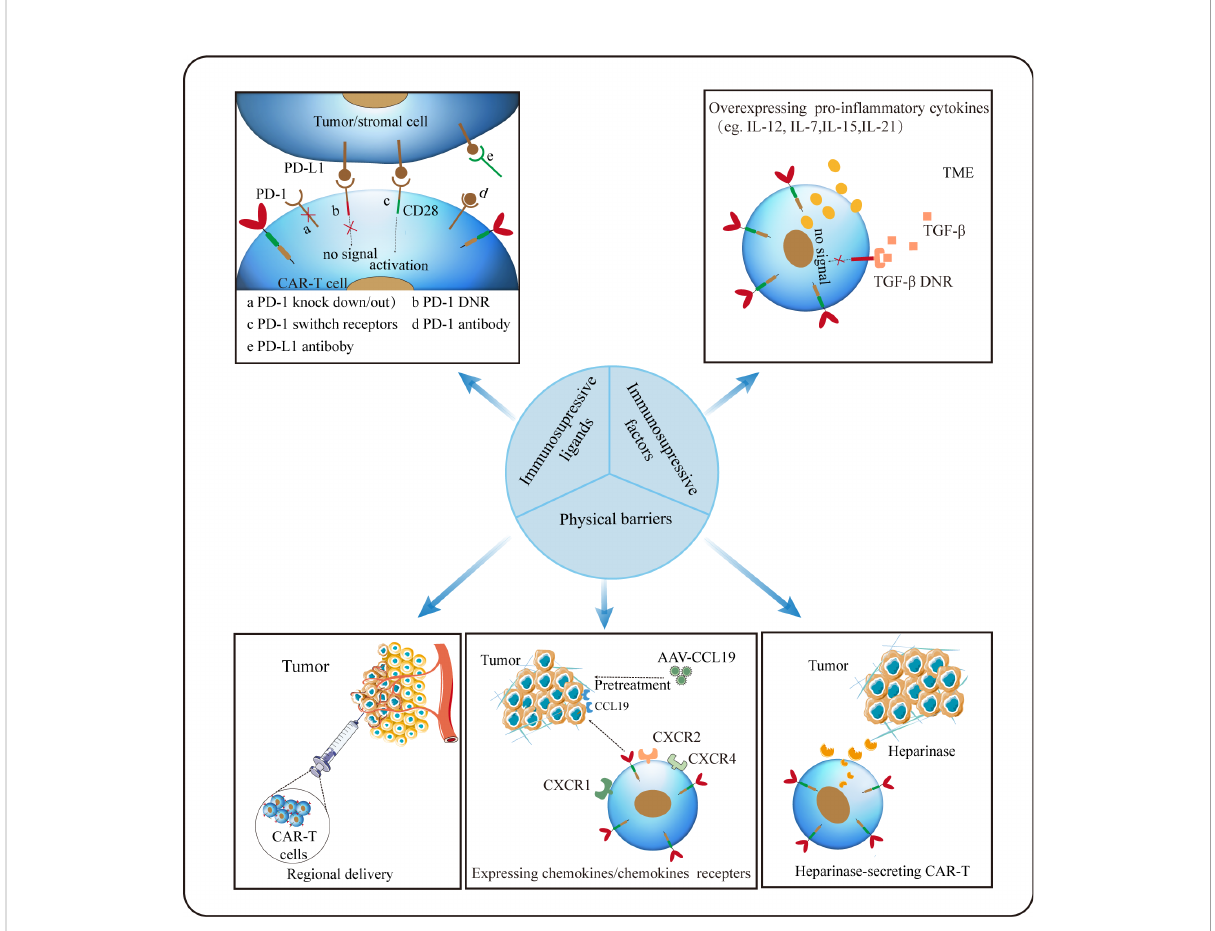
FIGURE 4 Strategies for CAR-T cells to overcome hostile TME. Regional delivery allows CAR-T cells to reach the tumor site directly. Inducing secretion of enzymes by CAR-T (eg. heparanase) to degrade ECM and optimizing CAR-T to express chemokines/chemokines receptors appears to remarkably improve CAR-T traf fi cking and in fi ltration. Disrupting the PD-1 expression on CAR-T cells or silencing/reversing the PD-1/PD-L1 axis can augment CAR-dependent antitumor activity. And modifying CAR-T to secrete pro-in fl ammatory factors may be an effective strategy against the inhibitory tumor